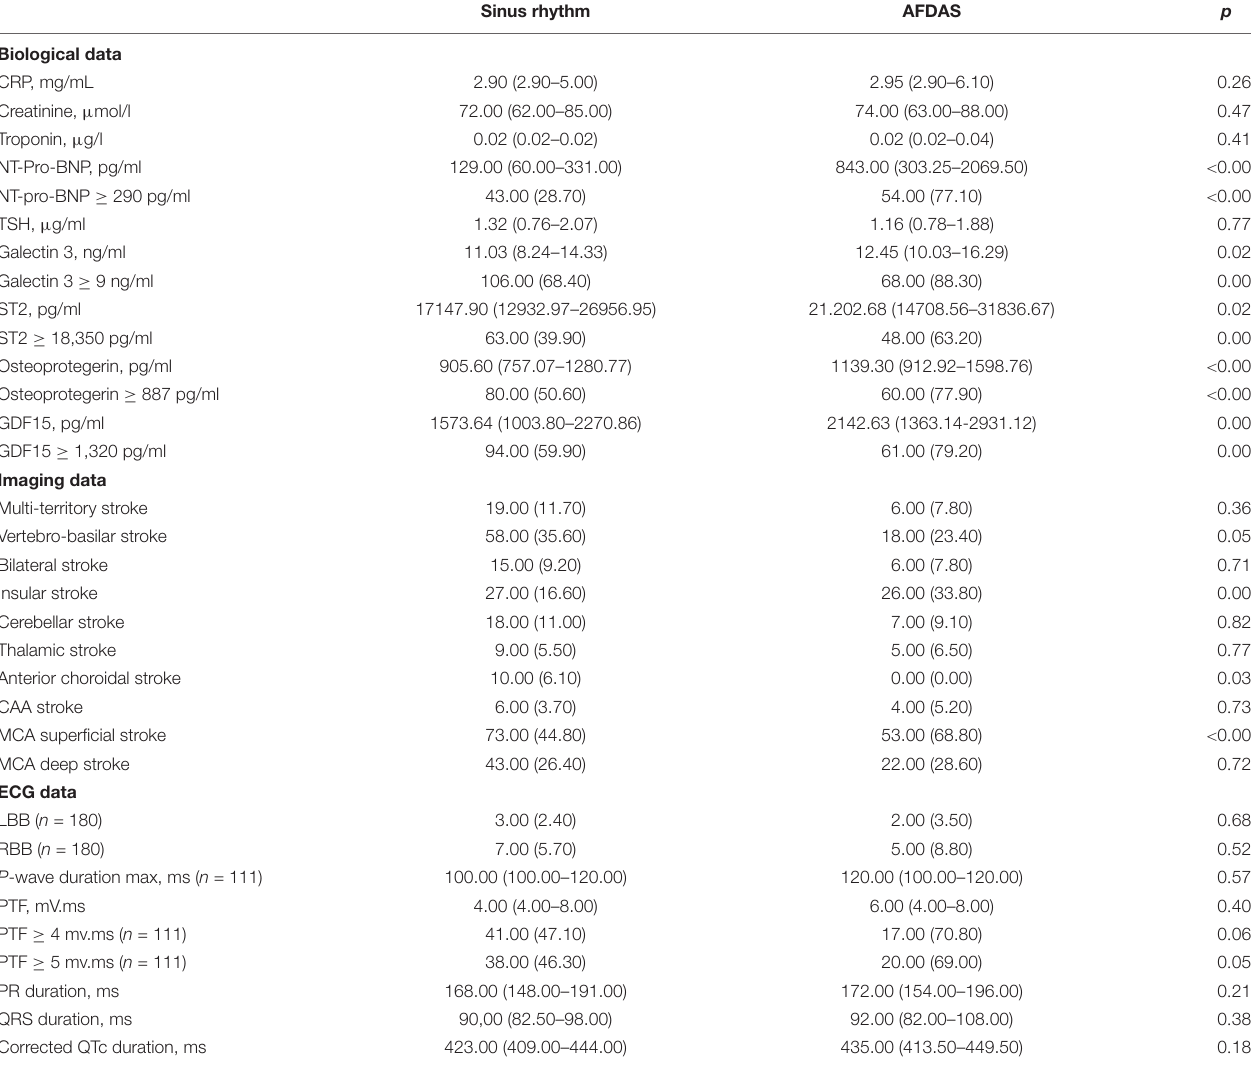
TABLE 2 | Biological, imaging and electrocardiographic characteristics of patients at admission [ n (%) or median (IQR)]. Sinus rhythm AFDAS